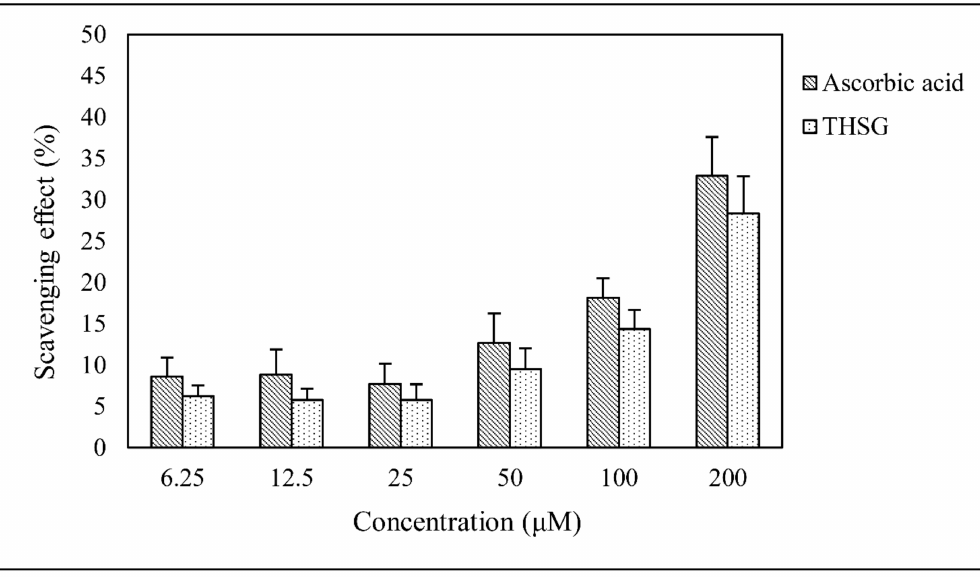
Figure 1. E ff ect of 2,3,4 (cid:48) ,5-Tetrahydroxystilbene-2- O - β -D-glucoside (THSG) (6.25–200 µ M) on 2,2-diphenyl-1-(2,4,6-trinitrophenyl)hydrazyl (DPPH) free radical scavenging activity. Ascorbic acid was used as a positive control. Data are presented as the mean ± SD, n =